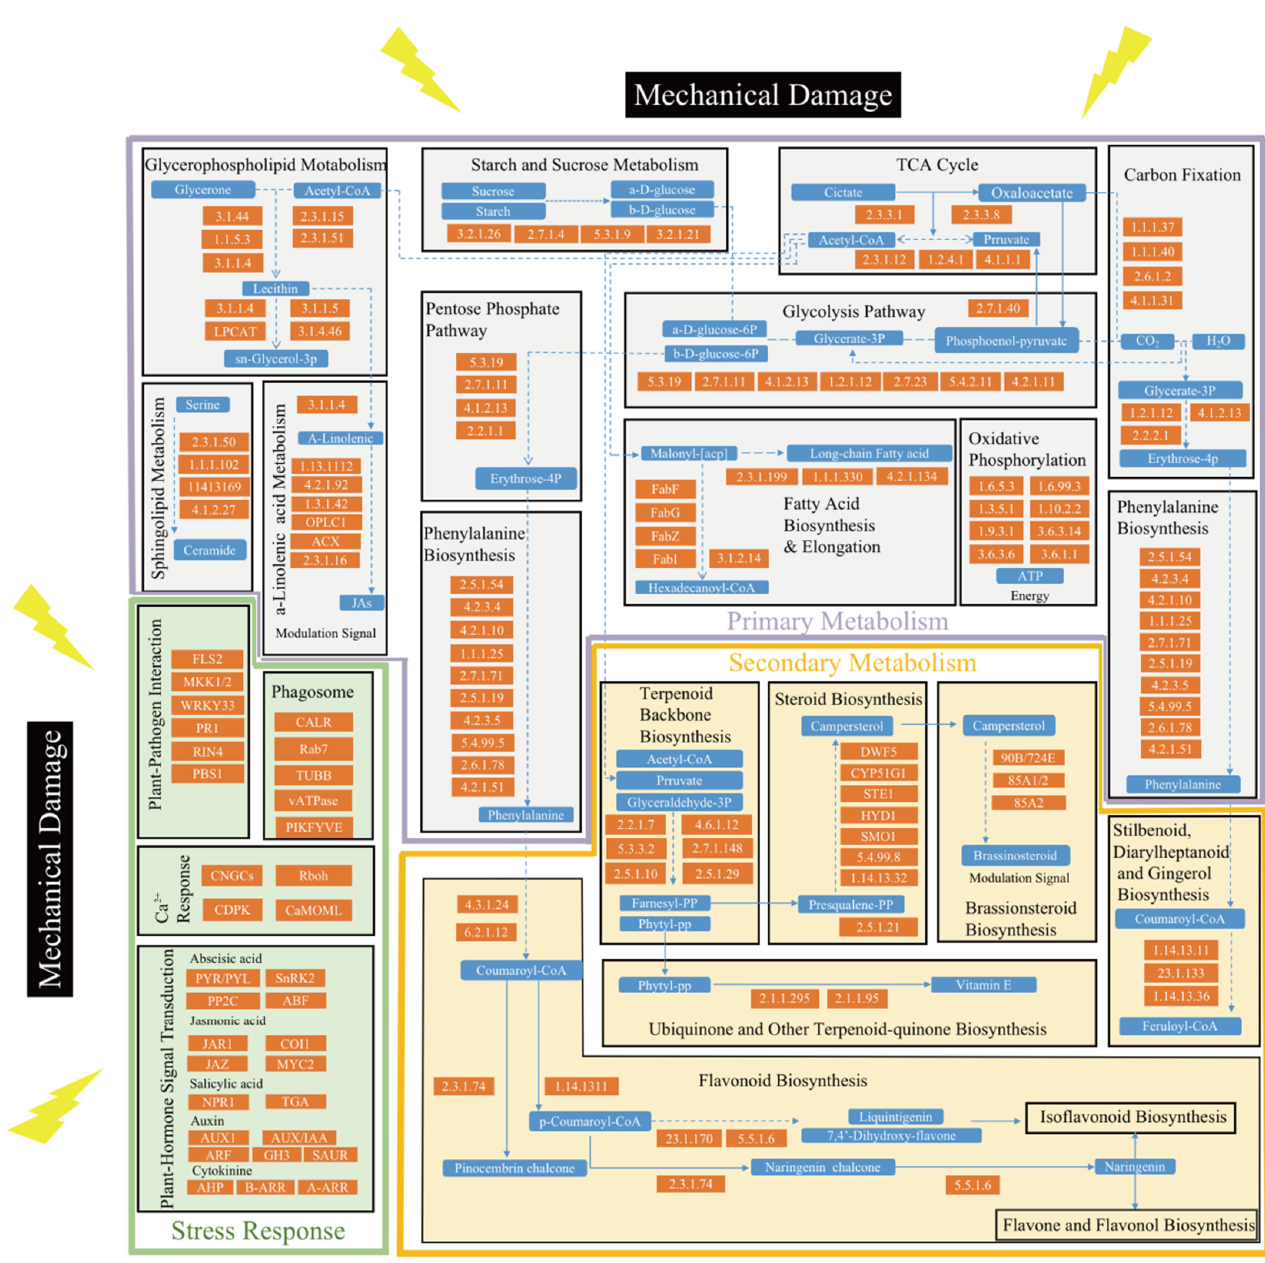
Figure 3. Connected KEGG Pathways of D. cochinchinensis under wound stress. The orange frame with numbers indicates upregulated genes; the blue frame indicates key metabolites; the full line indicates one-step reactions; the dotted line indicates reactions with multiple steps and the connec- tions among different pathways.